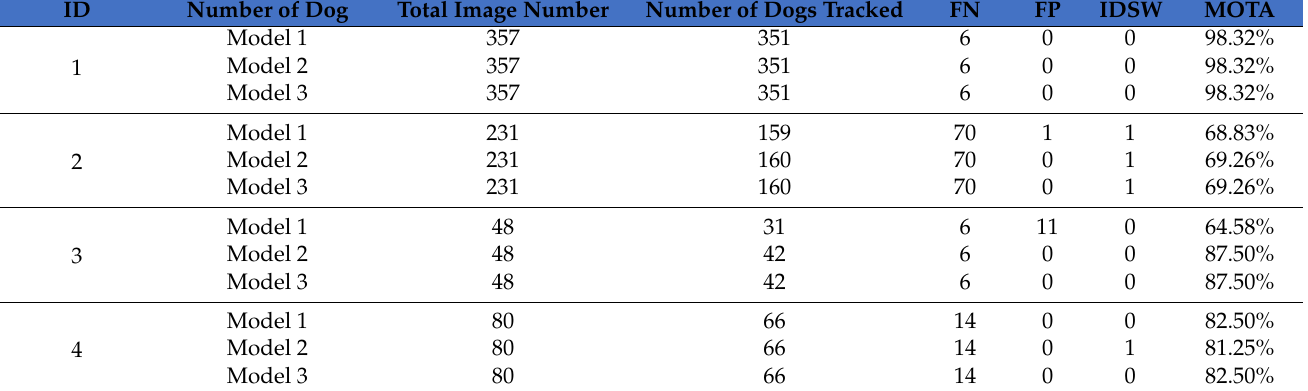
Table 14. Results of dog tracking experiments conducted using IMG_0014 data-set.